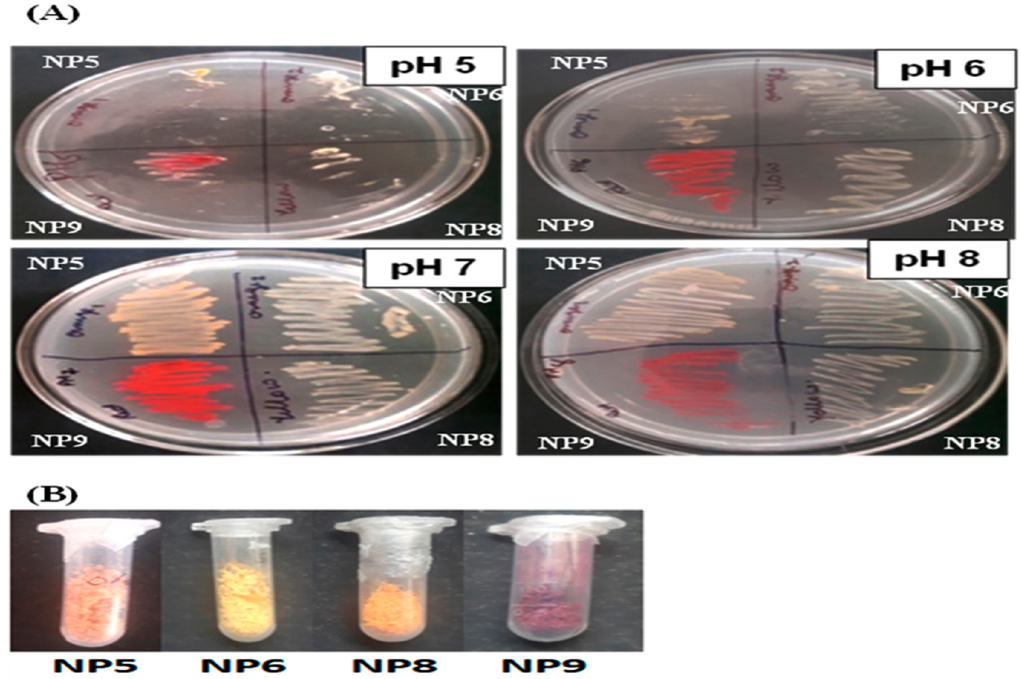
Fig. 2. (A) Pigment producing bacterial isolates at different pH (5.0, 6.0, 7.0 & 8.0): The pH 7.0 was found to be optimum for bacterial growth as well as pigment production. (B) Extracted Pigments from NP5 (Orange), NP6 (Yellow), NP8 (Orange) and NP9 (Red) isolates after drying: The dried form of pigments were weighed 0.122g, 0.576g, 0.323g & 0.231g per 150ml of culture